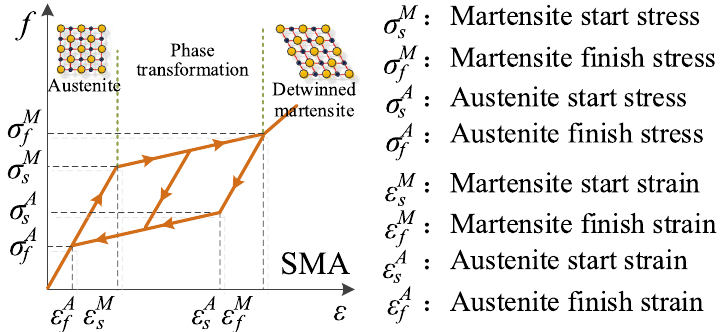
Fig. 2 the constitutive model of SMA (Auricchio 2001)